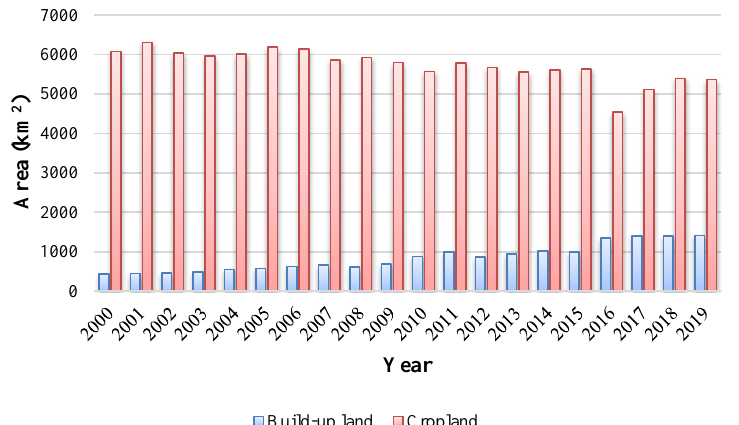
Figure 6. Built-up land and cropland changes.